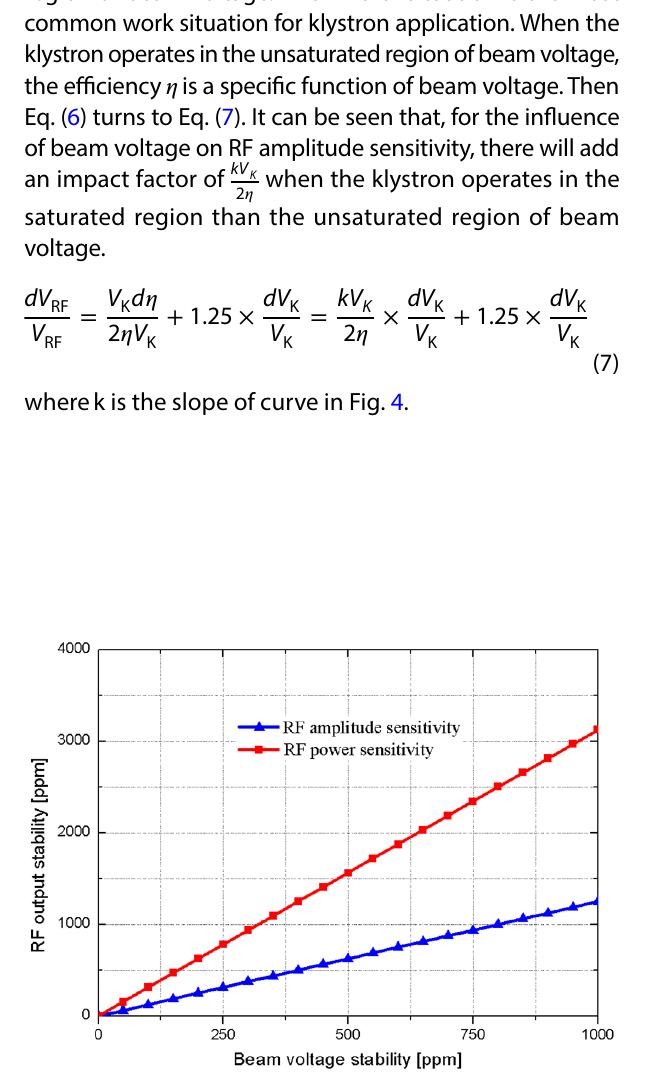
Fig. 4 Test data of efficiency and beam voltage of a klystron